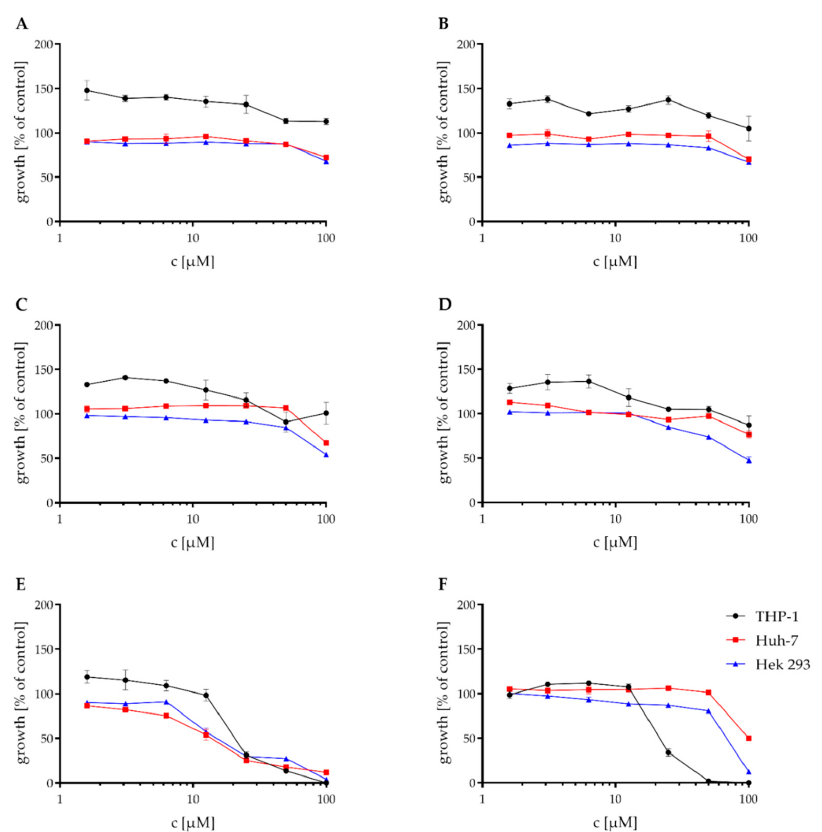
Figure 5. Effect of the natural products on the viability of THP-1, Huh-7, and HEK-293 cells. Cytotoxic effect of NK-A17e233 ( A ); 1,2-benzenediol,3-(4-hydroxy-2-methoxy-6-methylphenoxy)-5-methyl-(ACI) ( B ); cyperin ( C ); ES-242-1 ( D ); ES-242-3 ( E ); 5 S ,6 S -phomalactone ( F ) against the human cell lines THP-1, Huh-7, and HEK-293 as determined by resazurin assay. 100% growth control DMSO, 0% growth control cycloheximide. Values represent the means of triplicates ± SEM.